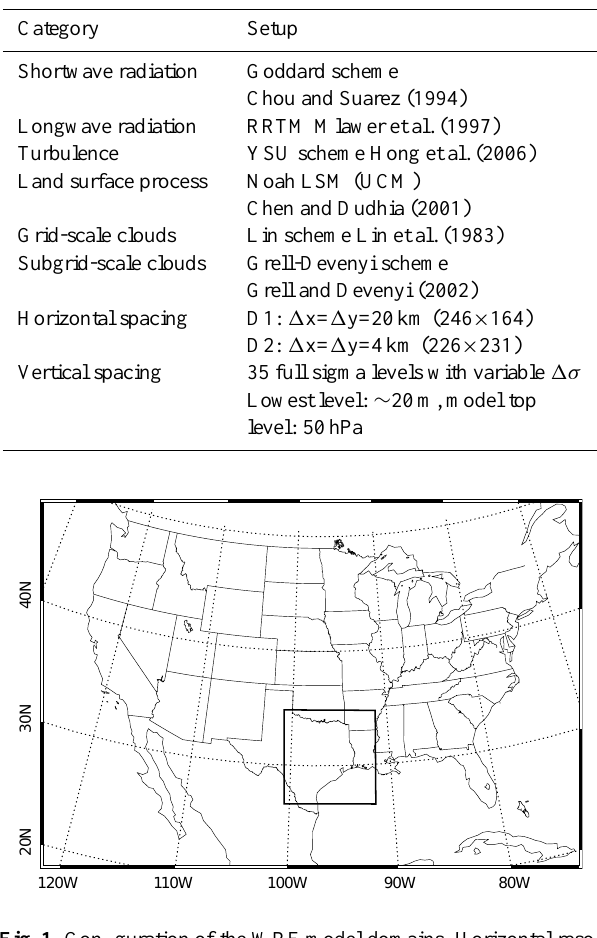
Fig. 1. Configuration of the WRF model domains. Horizontal reso- lution of the outer domain is 20km with a mesh of 246 × 164. The inner domain has a horizontal resolution of 4km with a mesh of 226 × 231.